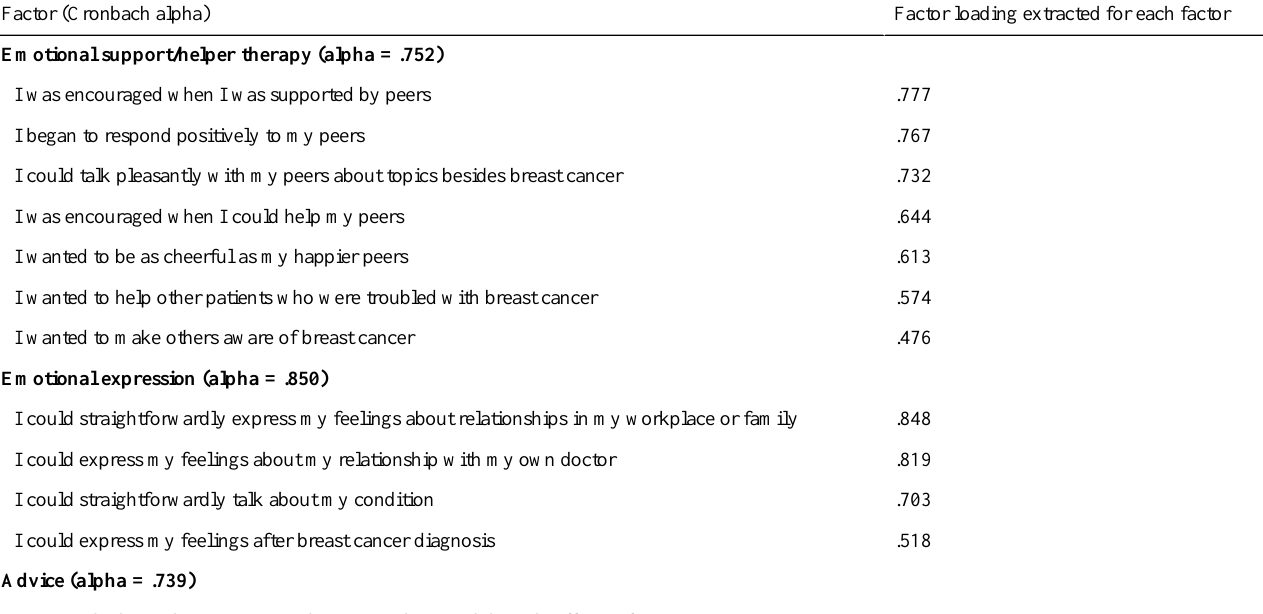
Table 3. Factor analysis of peer support functions for posters (n = 107) Emotional support/helper therapy (alpha =